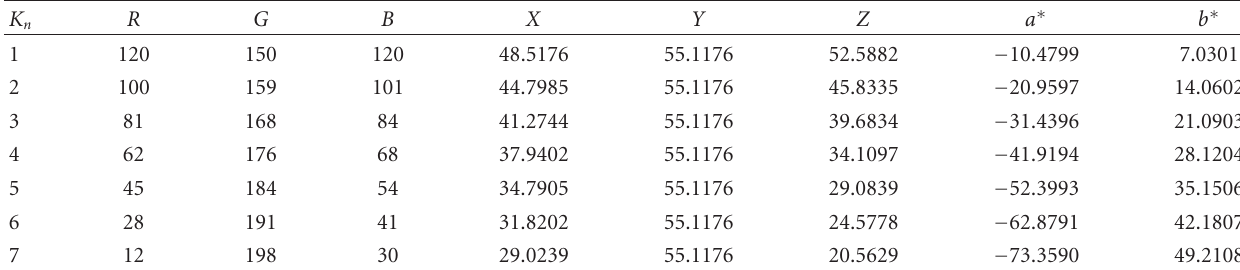
Table 1: The corresponding experimental calculating parameter of Figure 1.